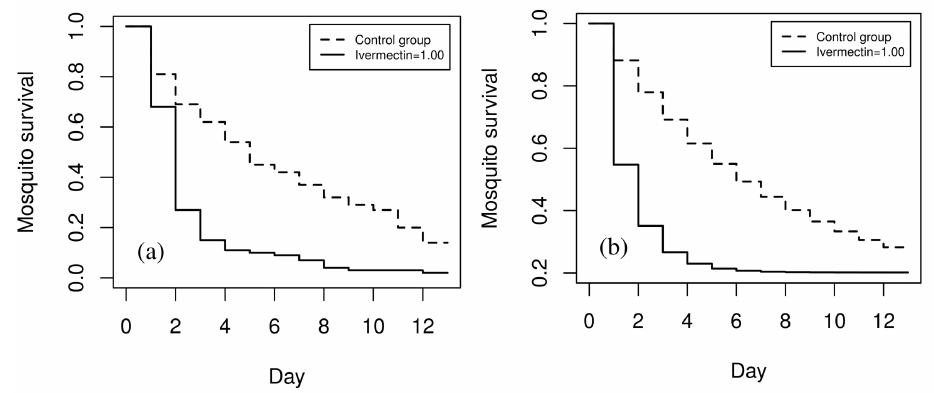
Figure 6. Validation of the ivermectin model: ( a ) mosquito survival curve in empirical series as a result of ivermectin treatment in 100% of all human individuals when compared to the untreated human control group [22] and ( b ) mosquito survival curve as a result of model simulation of ivermectin treatment in 100% of all human individuals when compared to a model simulation with no treatment in the control